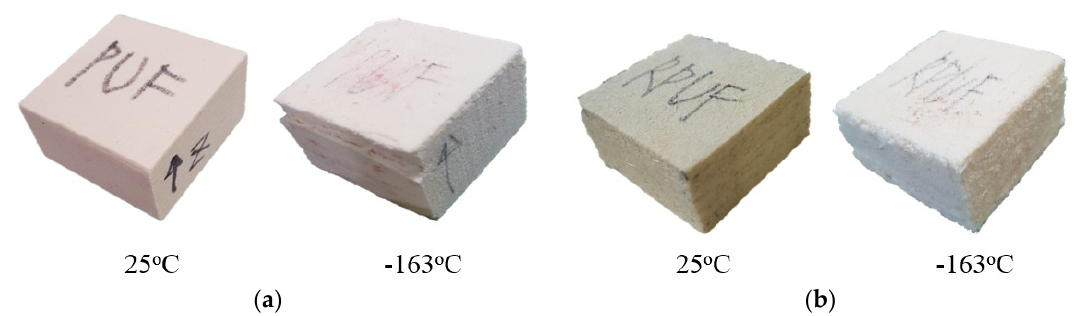
Figure 7. Shape of the specimens after the compressive test according to the temperature under restraint of the suggested compressive test: ( a ) pure PUF, ( b ) RPUF.